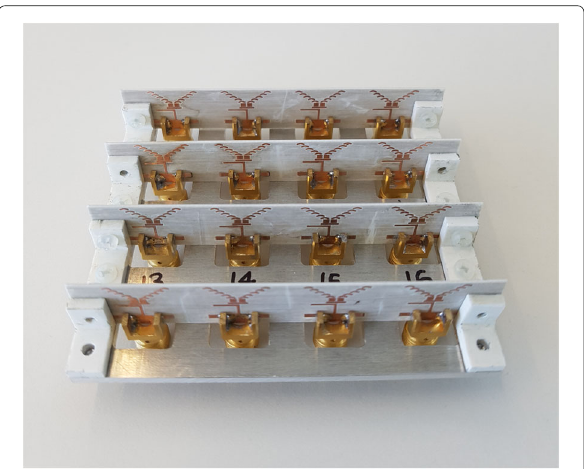
Fig. 3 Fabricated antenna for implementing RectAnt-SM Fig. 4 Phasing network of the designed